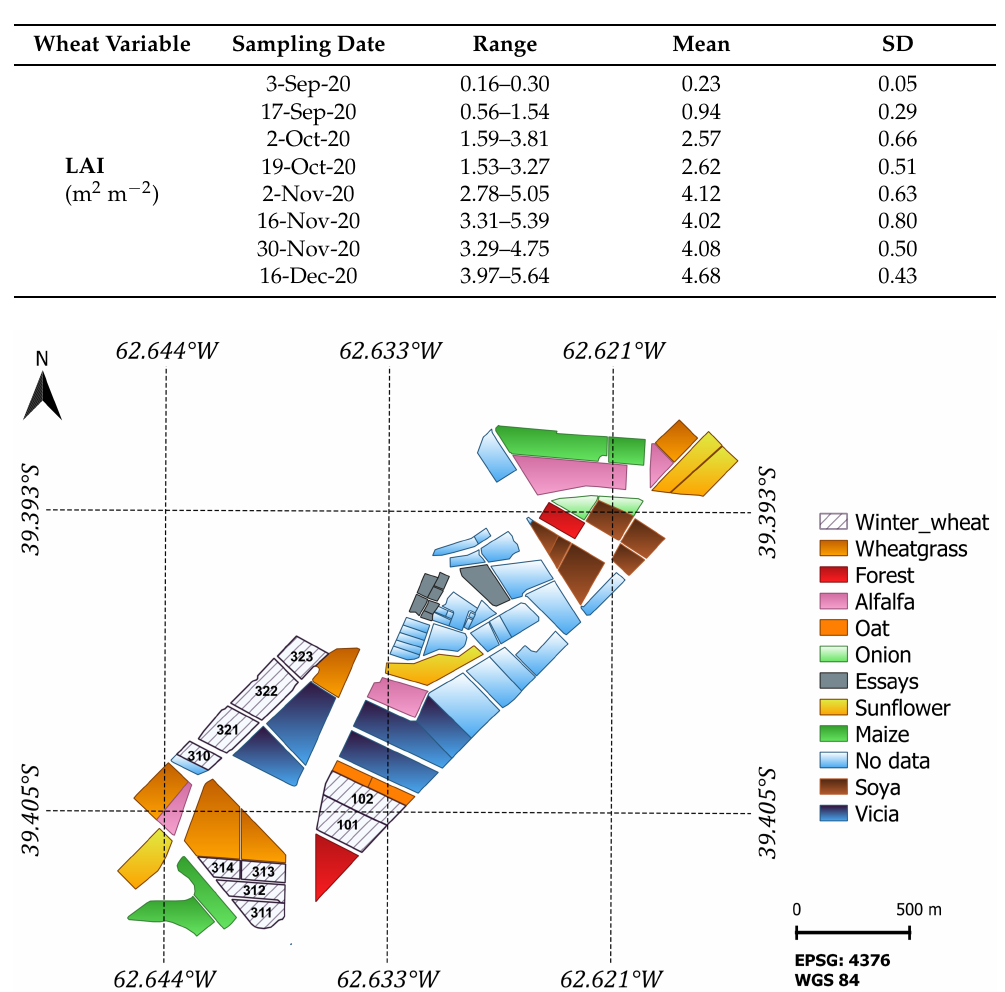
Table 1. LAI in situ measured database.